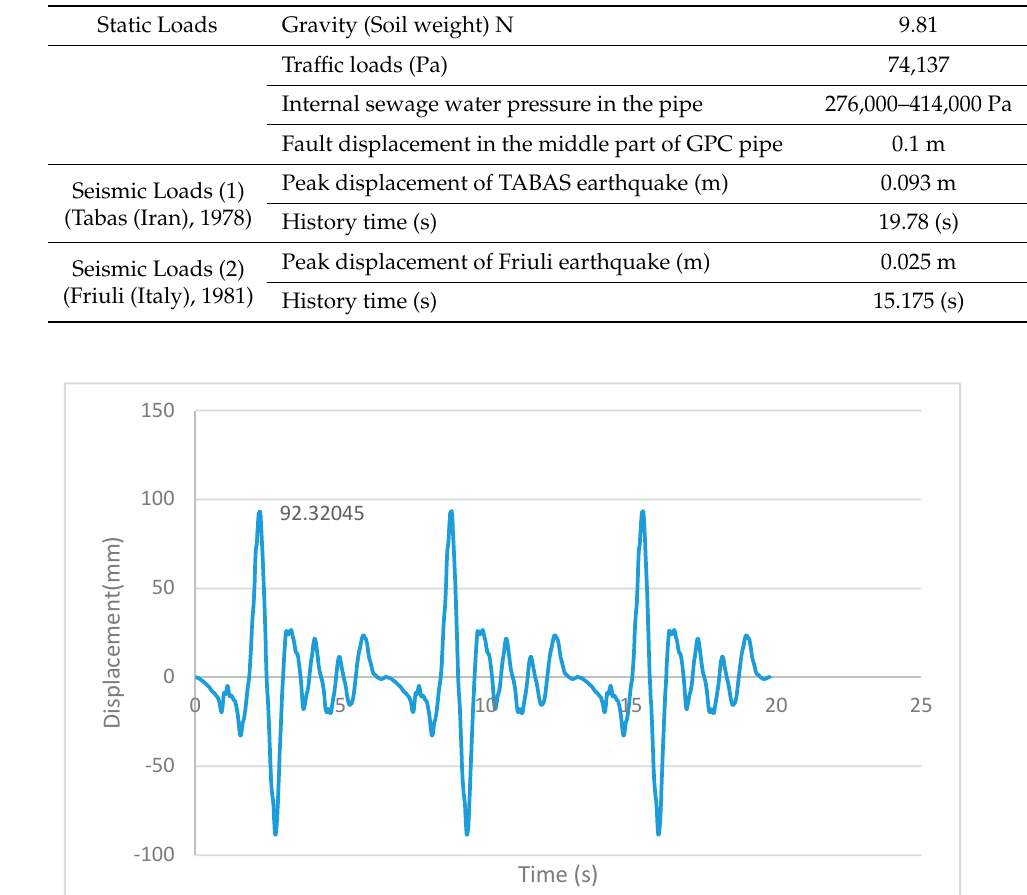
Figure 12. The accelerogram of the Tabas earthquake, Iran 1978 (Peer Ground Motion Database [43]).